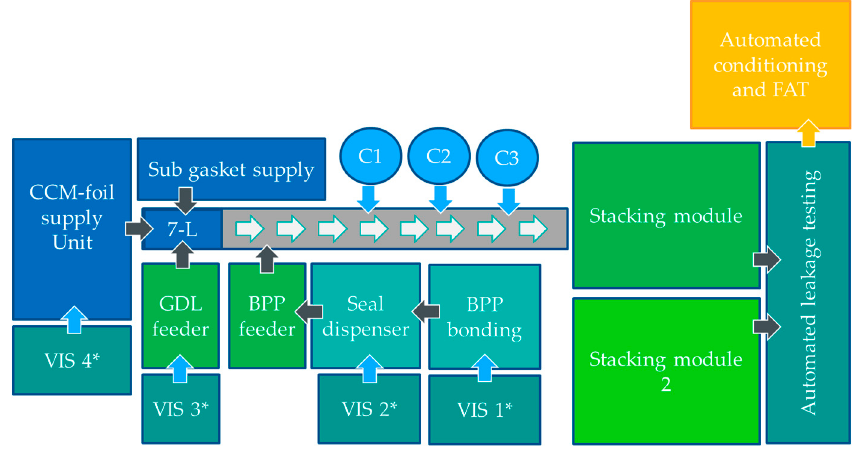
Figure 9. Schematic illustration of the modular MMM in an expanded form (* = expansion stage 2). VIS = high performance (visual) inspection systems; FAT = factory acceptance test.